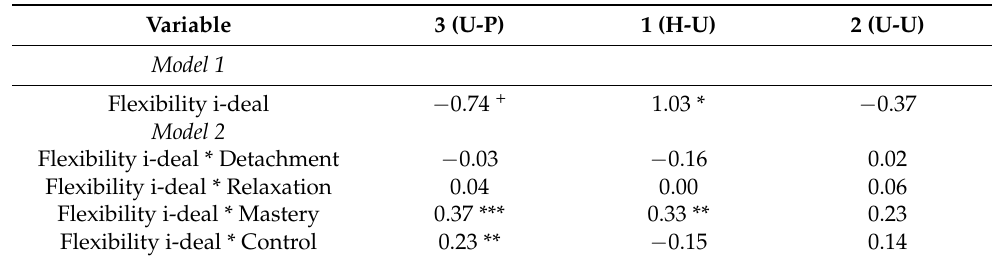
Table 4. Regression coefficients of flexibility i-deal moderated by recovery on Meaning of Work and Job Performance clusters (Study 2; N = 281).